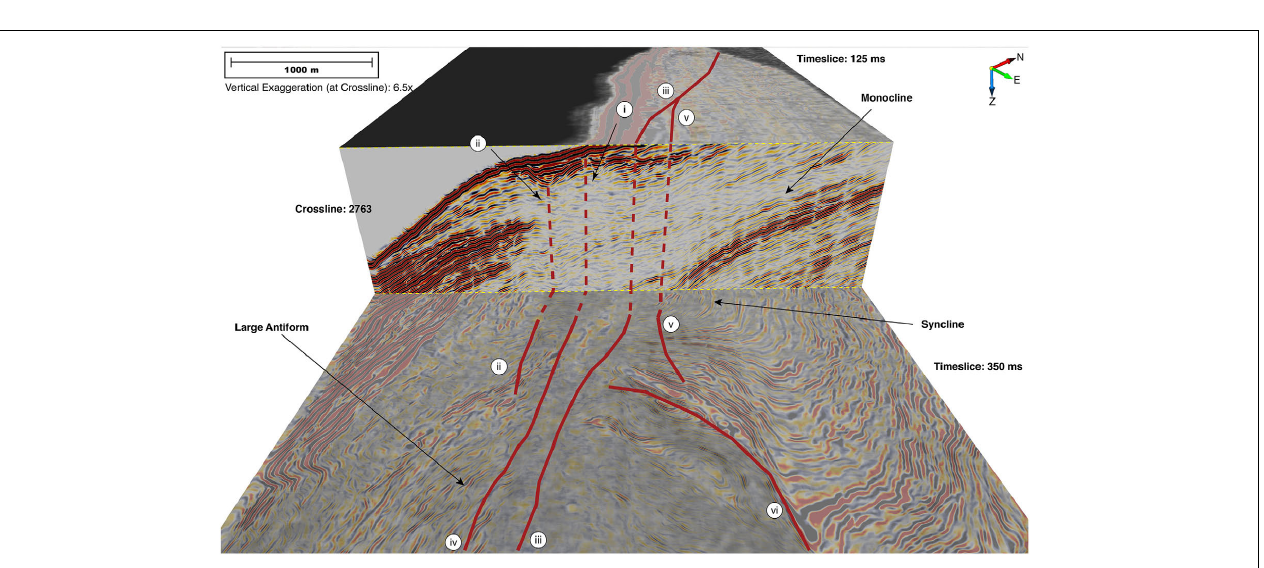
FIGURE 8 | Interpreted stair diagram of crossline 2763 using amplitude data for the crossline and bounded by time-slices at 125 and 350 ms rendered using similarity seismic attribute. Stratigraphy is acoustically transparent in the center of the crossline, possibly due to fluid presence or fault damage from large fault segments in crossline. Fault interpretations are shown with solid red lines; dashed where there is more uncertainty. A monocline to the north exhibits sloped stratigraphy to the south. Stratigraphy along shelf edge maintains a shallower dip and stronger reflections at